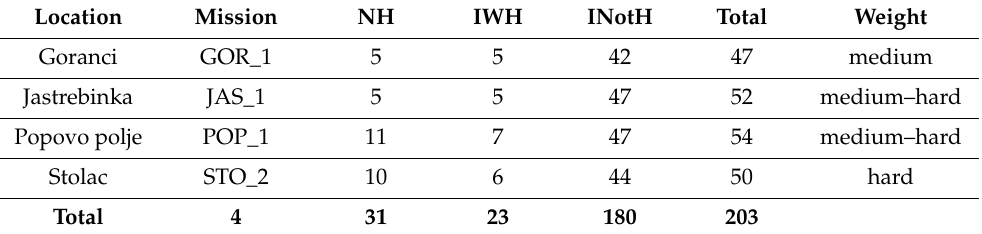
Table 2. Information about SAR missions used within this experiment; NH—number of persons, IWH—number of images without persons, INotH—images without persons.